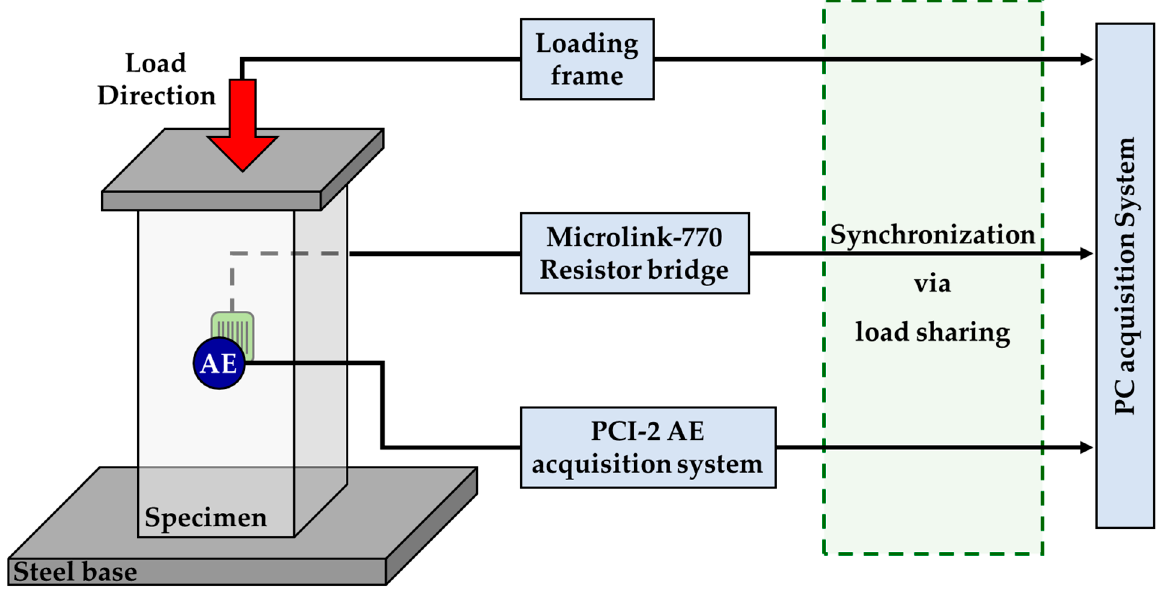
Figure 1. Experimental set-up of the described loading protocols.